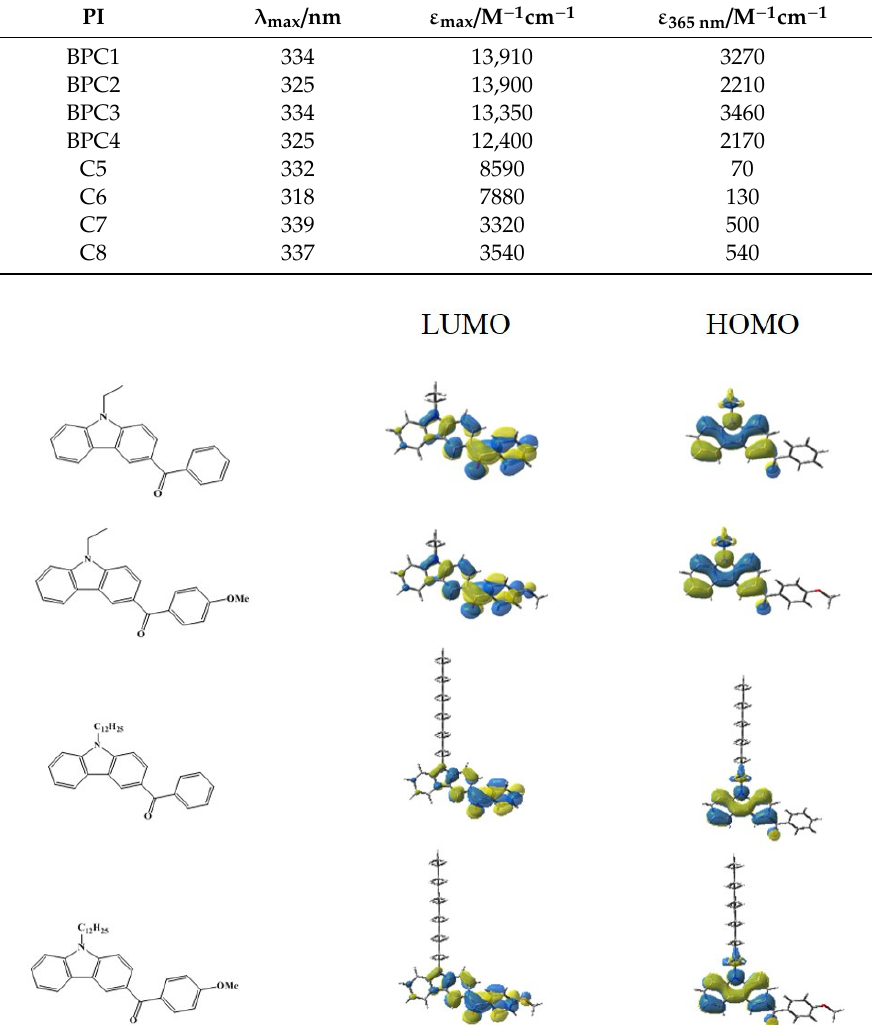
Figure 1. UV-visible absorption spectra of the carbazole derivatives in acetonitrile.